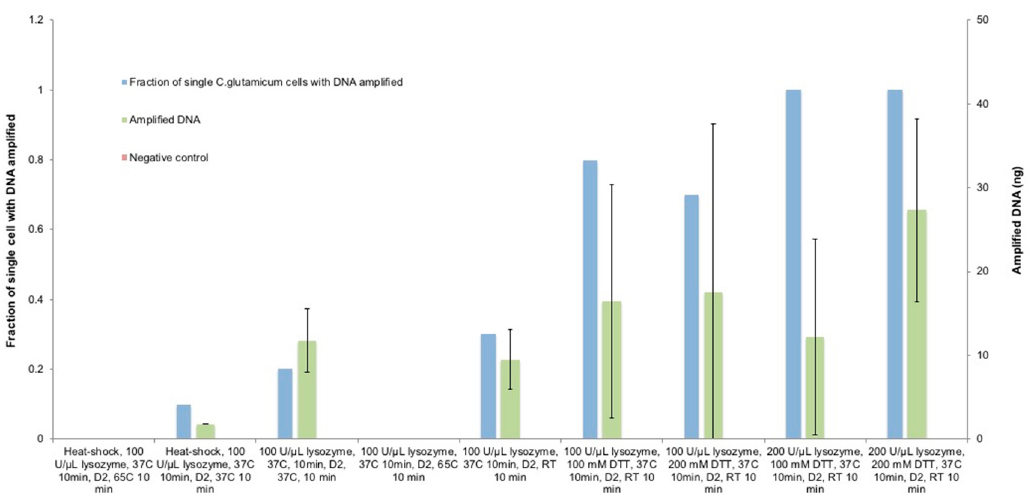
Figure 5. The optimization of the combined effect of thermal treatment, lysozyme, and DTT on C. glutamicum lysis to reach the optimal condition for subsequent SC-WGA. N = 10 single cells per condition, error bars represent standard deviation.